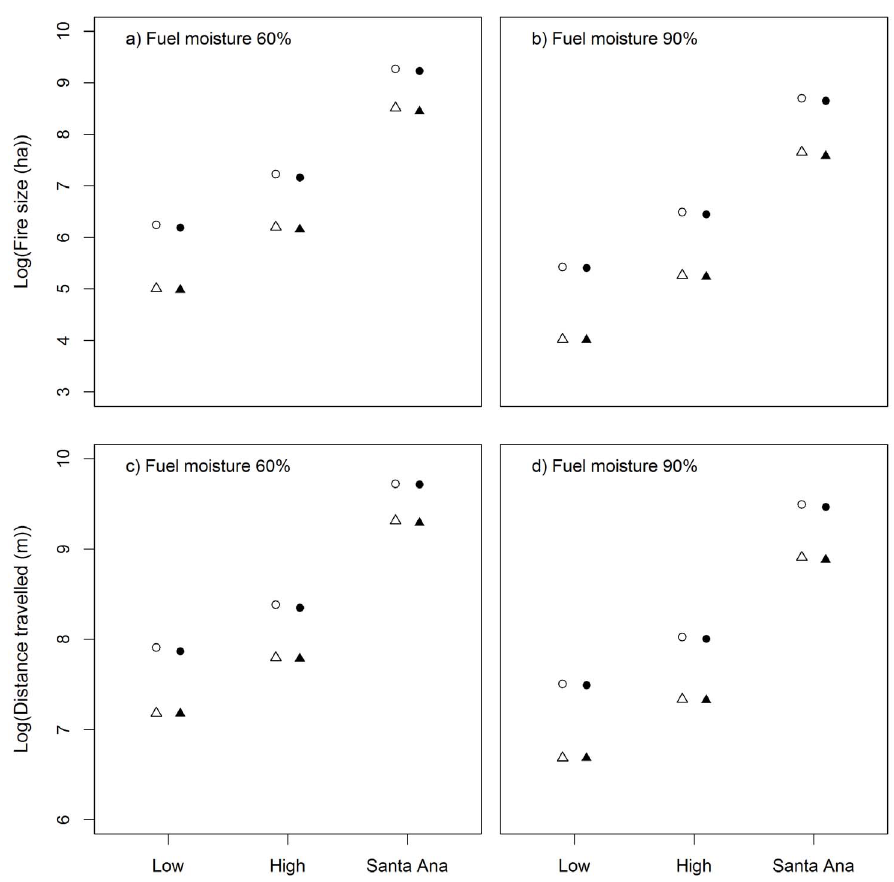
Figure 3. Relationships from the FARSITE simulation data between weather and fire size with fuel moisture of a) 60% and b) 90%, and distance travelled with fuel moisture of c) 60% and d) 90%. Open symbols are for simulations with no fuel breaks, closed symbols for simulations with fuel breaks. Circles represent a high landscape fuel load scenario and triangles represent a low landscape fuel load scenario. NB 95% confidence intervals were too small to depict in the graphics.